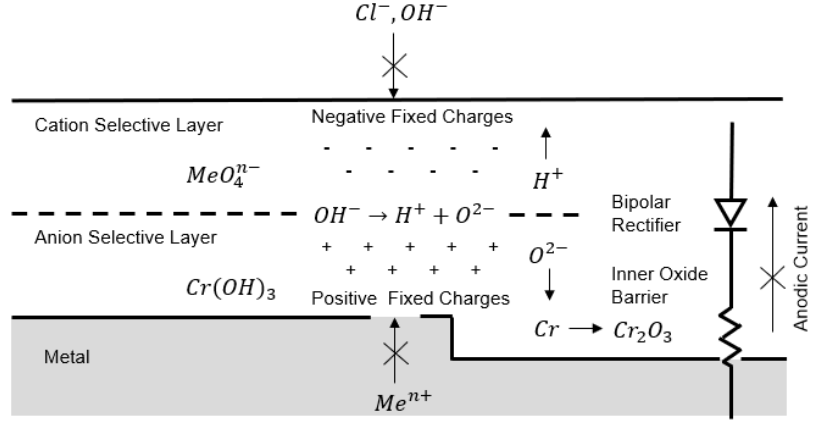
Figure 8. Schematic: bipolar passive film model (adapted from [72]).